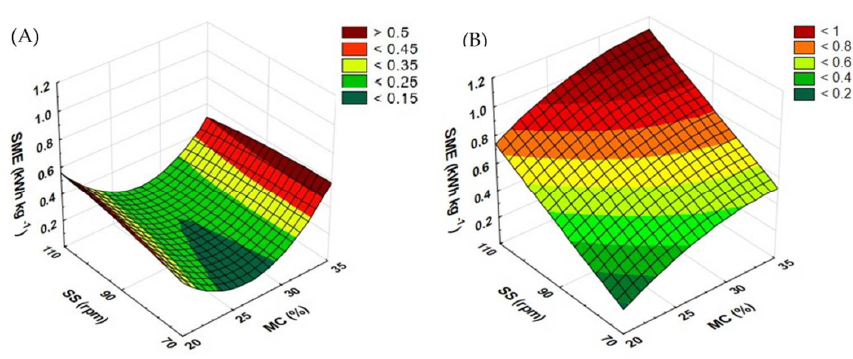
Figure 6. Specific mechanical energy of the extrusion-cooking of rapeseed straw ( A ) and buckwheat straw ( B ) before modification of the plasticizing system: MC—moisture content; SS—screw speed; SME—specific mechanical energy.